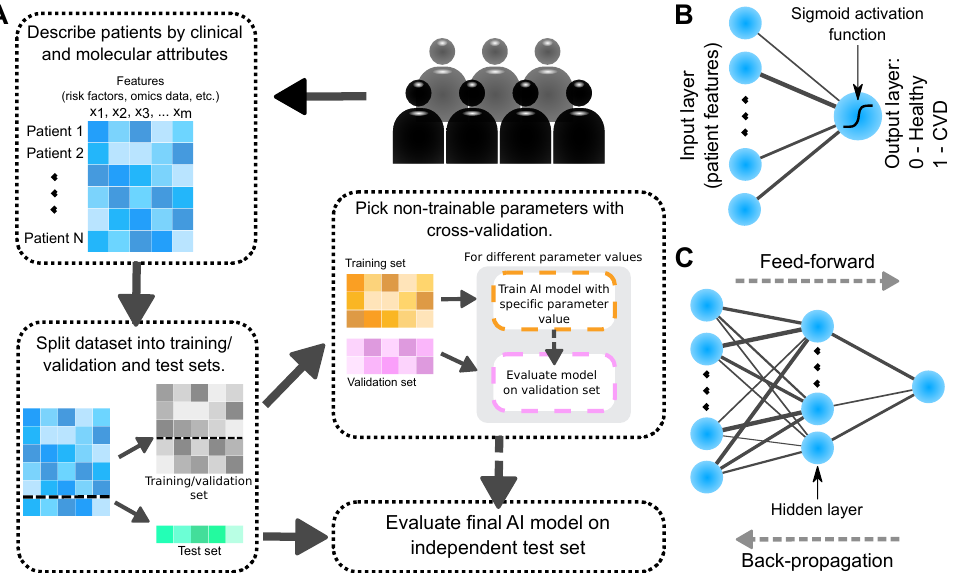
Figure 2. ( A ) Illustration of a typical AI workflow. Each patient is first described by the same set of numerical and/or categorical attributes (features), such as risk factors or gene expression levels. The data (patients) are then divided into training, validation and test sets. AI models with different values of non-trainable parameters (hyperparameters) are trained on the training set. The model performance is evaluated on the validation set according to some metric. A final model with the hyperparameters yielding the best validation-set performance is then evaluated on the independent test set. ( B ) Illustration of a perceptron neural network with a sigmoid activation function. ( C ) Illustration of a multi-layer neural network with one hidden layer. The arrows indicate direction of feed-forward and back-propagation